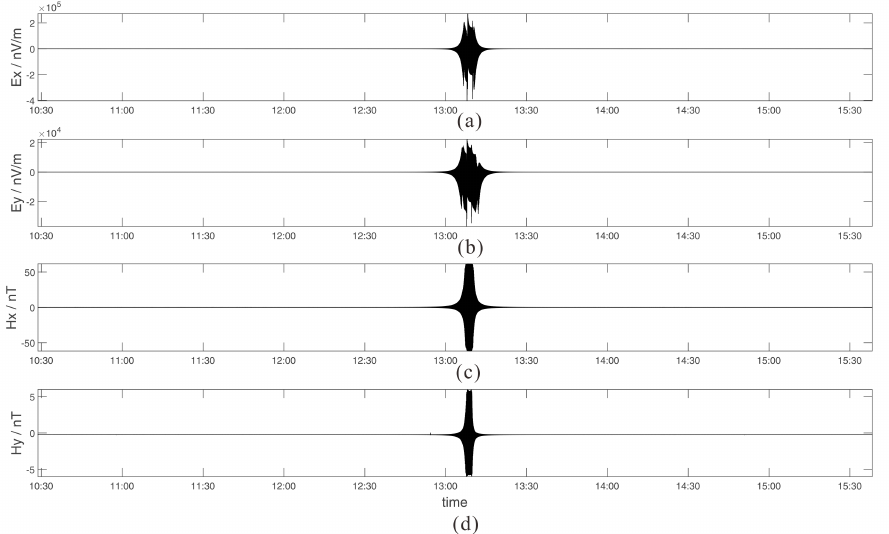
Figure 10. Four horizontal electromagnetic components of the 2nd receiver. ( a ) is the Ex component, ( b ) is the Ey component, ( c ) shows the Hx component and ( d ) is the Hy